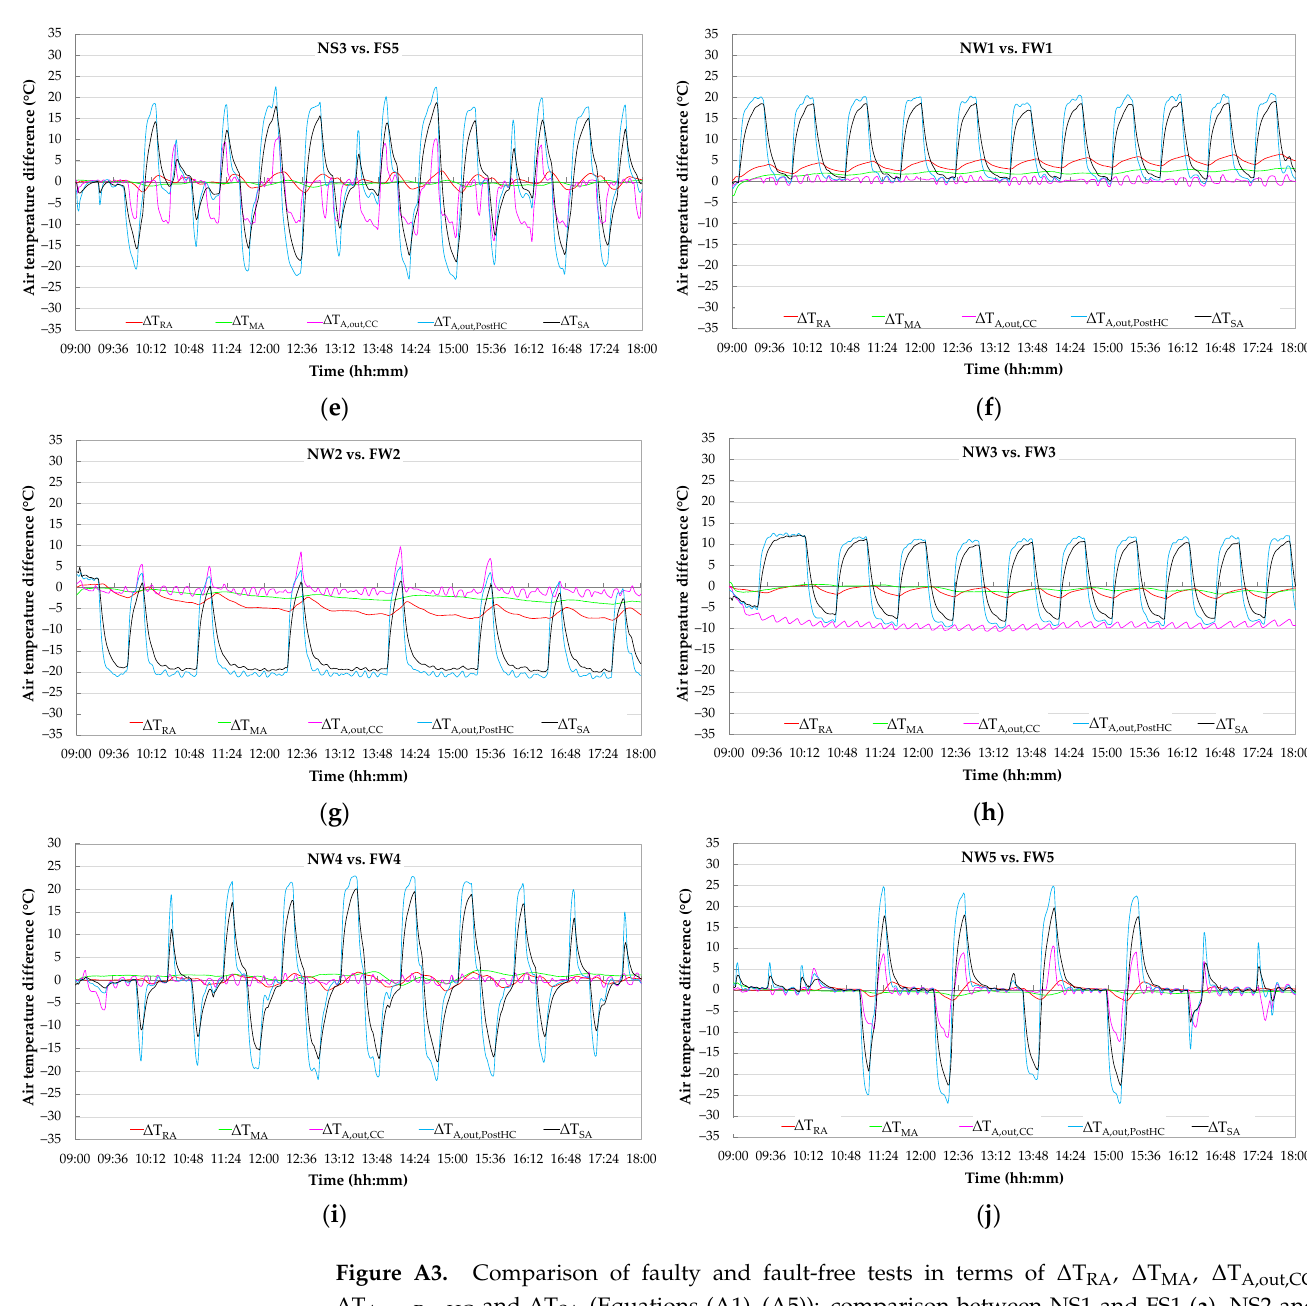
Figure A3. Comparison of faulty and fault-free tests in terms of ∆ T RA , ∆ T MA , ∆ T A,out,CC , ∆ T A,out,PostHC and ∆ T SA (Equations (A1)–(A5)): comparison between NS1 and FS1 ( a ), NS2 and FS2 ( b ), NS2 and FS3 ( c ), NS1 and FS4 ( d ), NS3 and FS5 ( e ), NW1 and FW1 ( f ), NW2 and FW2 ( g ), NW3 and FW3 ( h ), NW4 and FW4 ( i ), NW5 and FW5 ( j ).